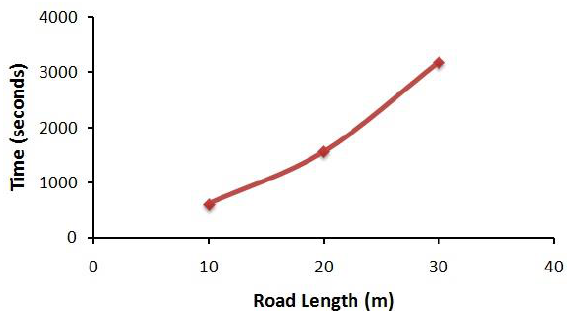
Figure 5: Plot of the time taken by the snake curve to move from its initial position to the final position in the three test cases of input data dimension analysis.